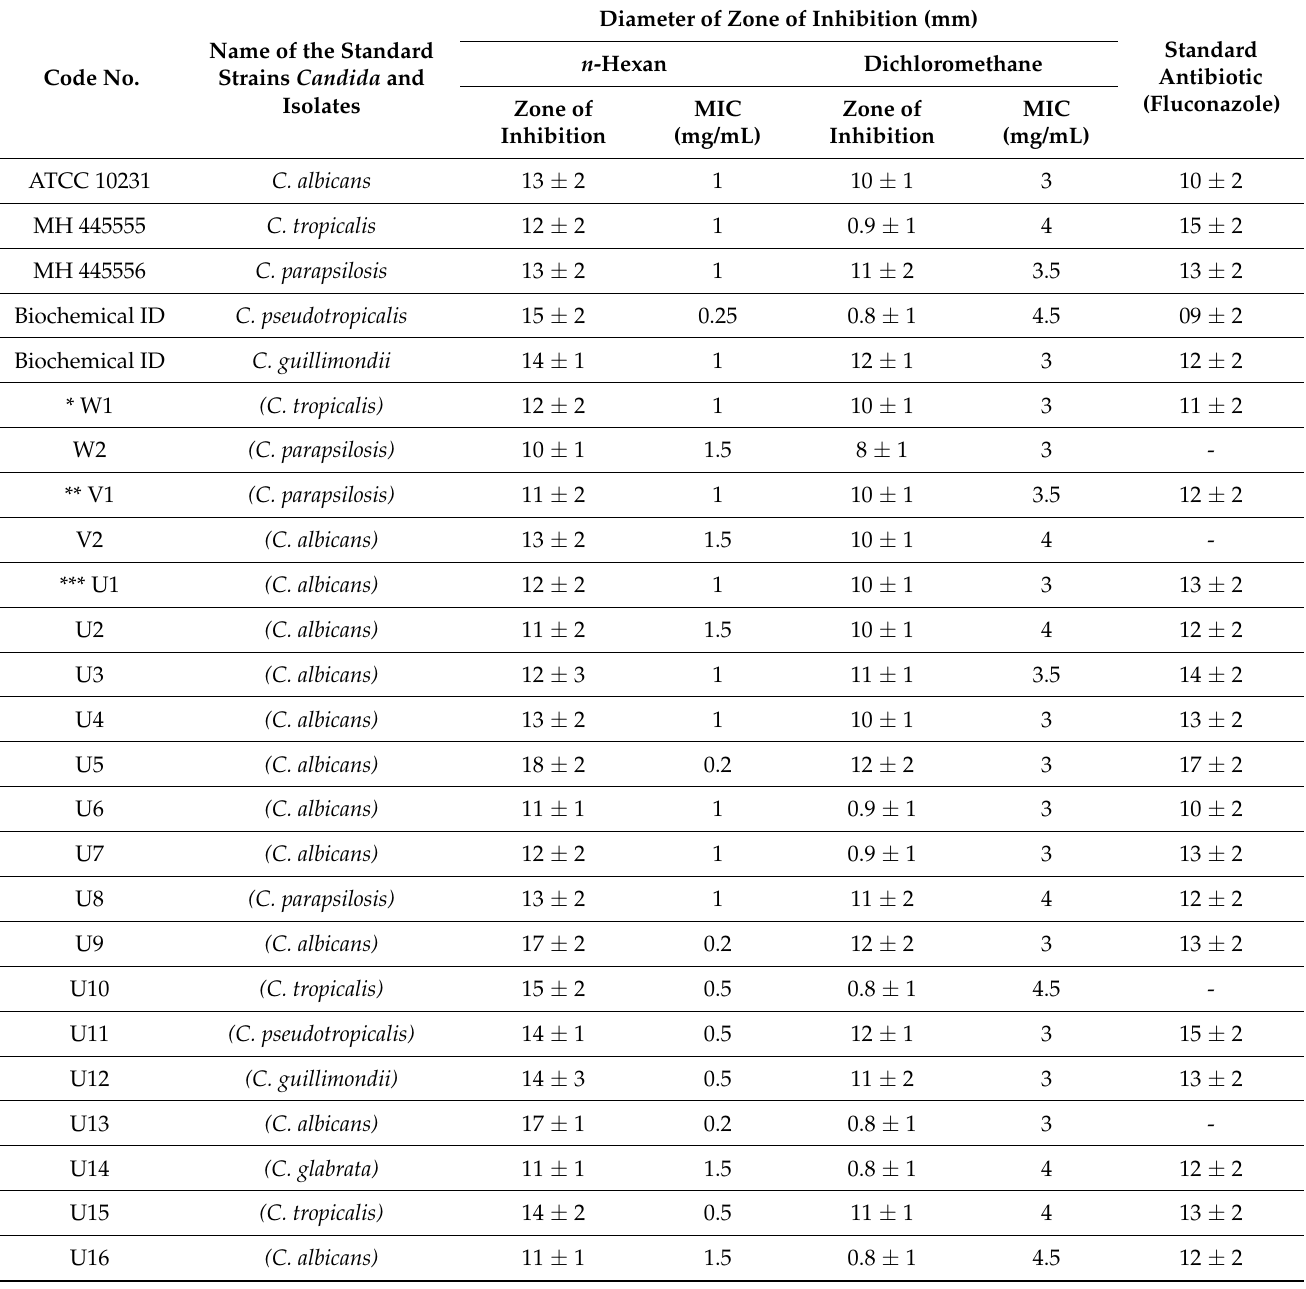
Table 2. Anticandidal activity of n -hexane and dichloromethane extracts of Saussurea costus against Candida strains and